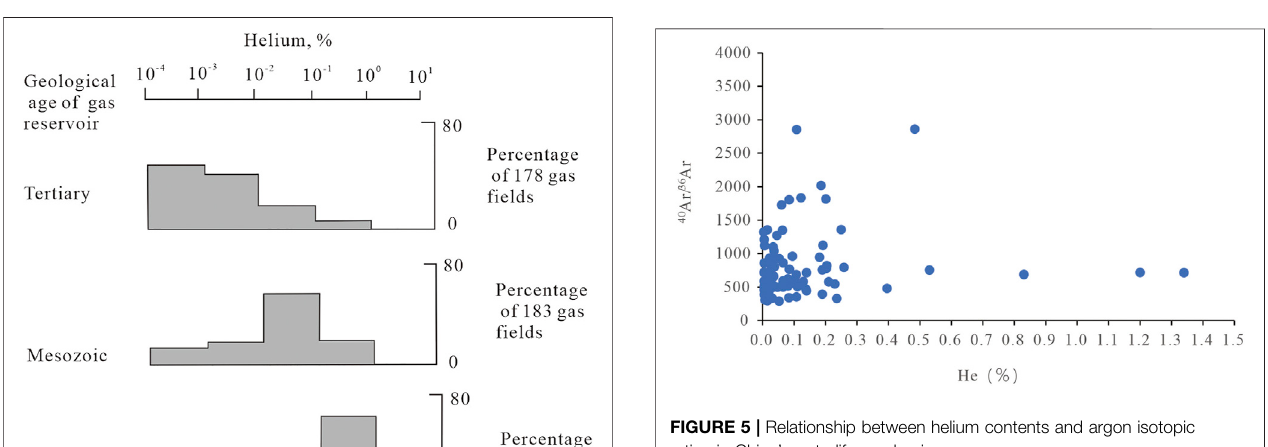
FIGURE 5 | Relationship between helium contents and argon isotopic ratios in China ’ s petroliferous